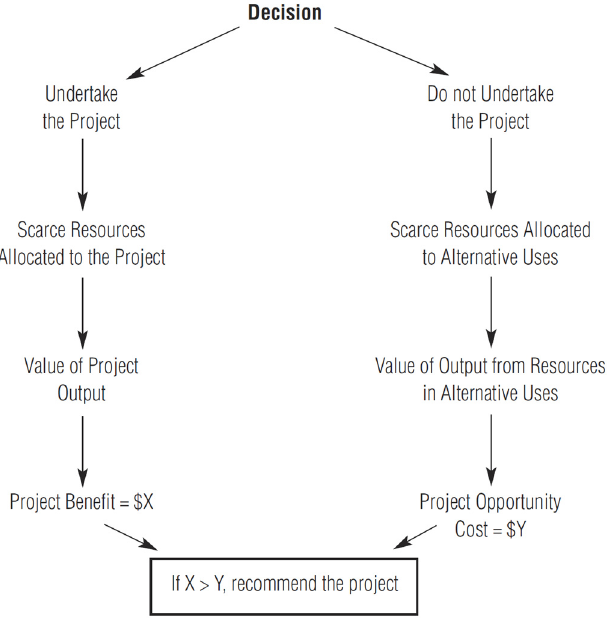
Figure 14. The ‘with and without’ approach to cost–benefit analysis